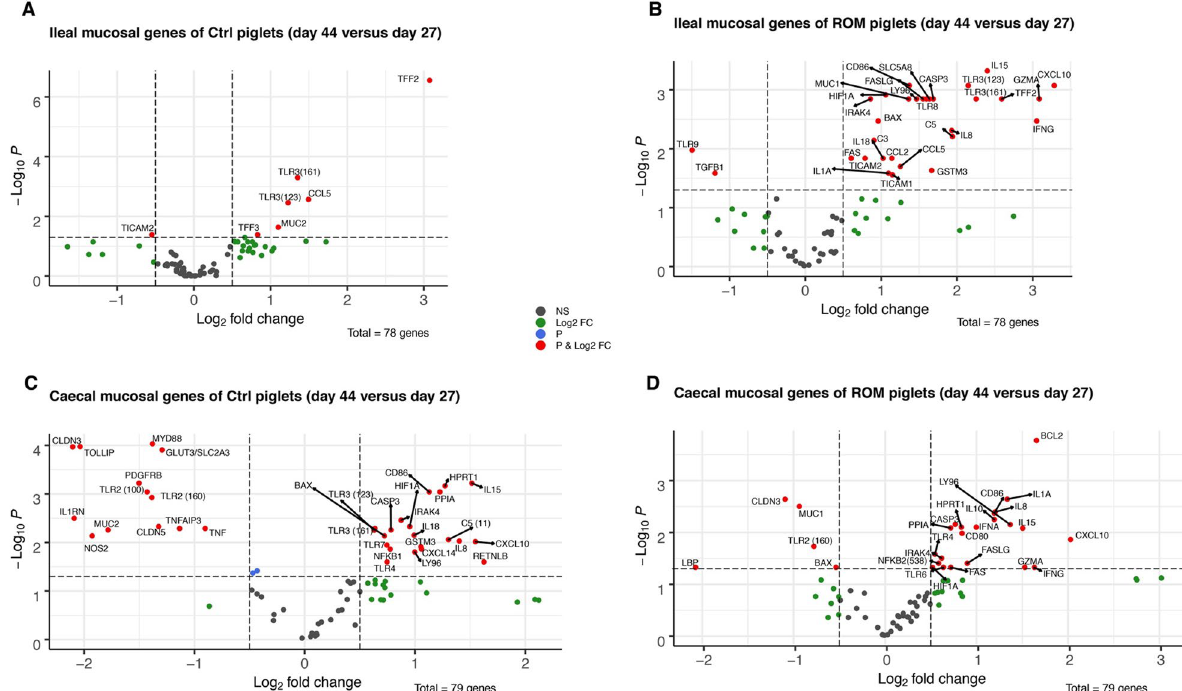
Fig. 6 Volcano plots of all expressed genes in mucosa collected from ileum of Ctrl‑ ( A ) and ROM ( B ) piglets, as well as from caecum of Ctrl‑ ( C ) and ROM ( D ) piglets by comparisons between day 44 and day 27 within each group. The x‑axis is the log2 fold change (log2 FC) for the ratio day 44 versus day 27 and the y‑axis is the log10 p value that was adjusted by FDR for multiple testing. The red dots represent genes that were − either significantly more (positive fold‑change) or less (negative fold‑change) expressed on day 44 versus day 27 for the respective location and experimental group, with adjusted p 0.05 and a log2 FC > 0.5. Blue points indicate differentially expressed genes with an adjusted p < 0.05 and a ≤ log2 FC < 0.5. Green points indicate differentially expressed genes with adjusted p > 0.05 and a log2 FC >